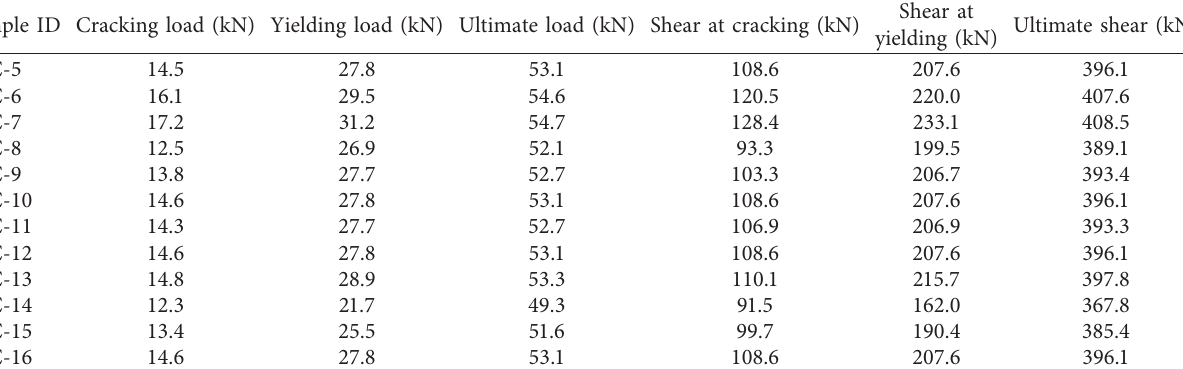
Table 11: Beam end loads and shear from